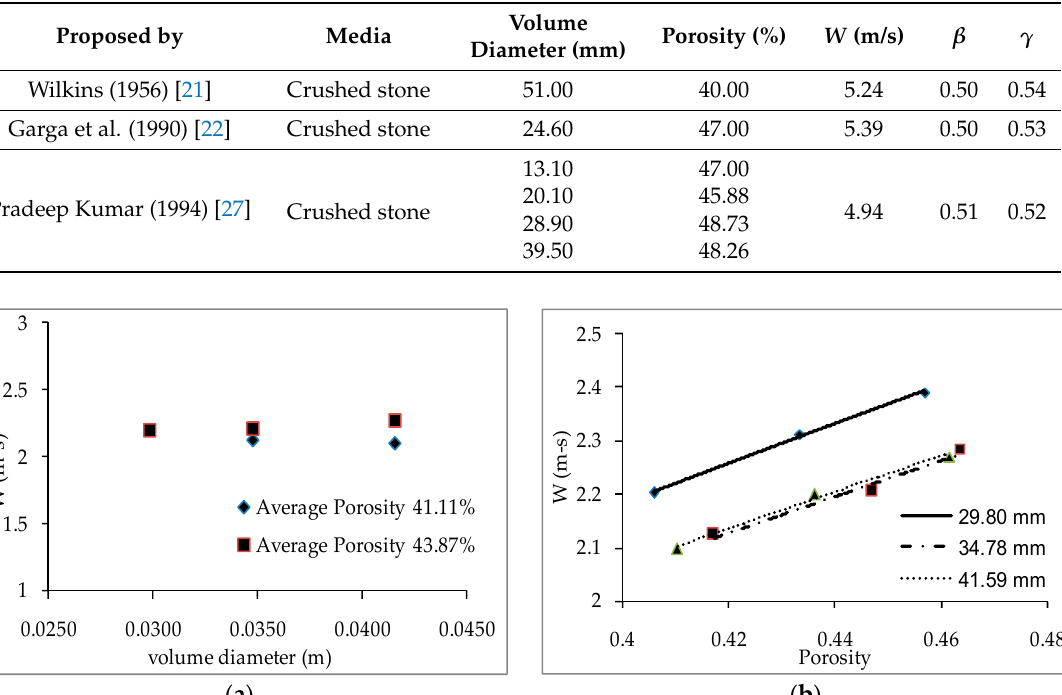
Table 3. The values of the Wilkins coefficients as reported by earlier researchers.